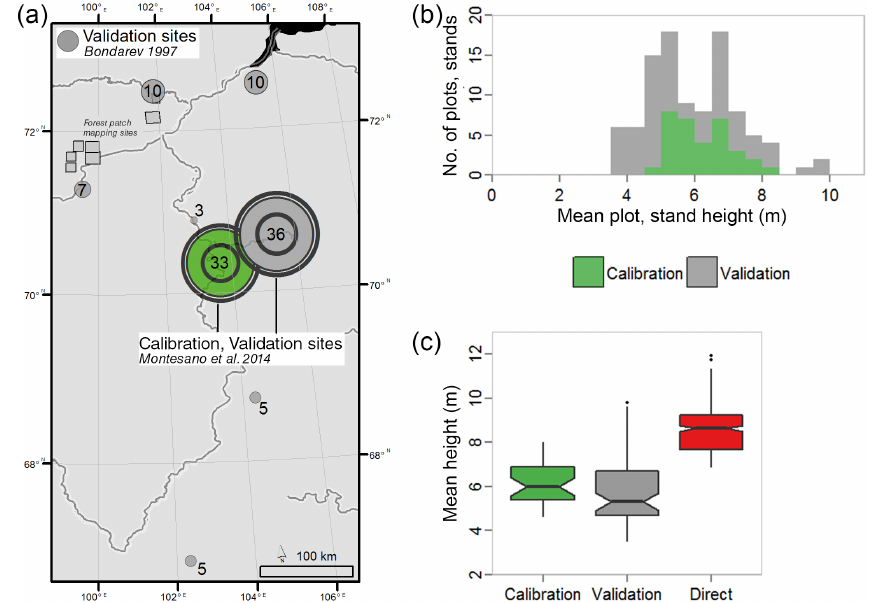
Figure 4. (a) Map of locations of calibration (green) and validation (grey) sites in northern Siberia with the number of stands or plots associated with each site. The circles representing general site locations are sized according to the number of stands. (b) Histogram of mean plot and stand heights from calibration and validation data. (c) Comparison of the distribution of mean height of calibration and validation plots and stands with that of forest patches heights from direct estimates. Notched boxplots showing the 25th, 50th, and 75th percentiles of mean height as horizontal lines and 1.5 times the interquartile range as vertical lines. Notches roughly indicate the 95% confidence interval for the